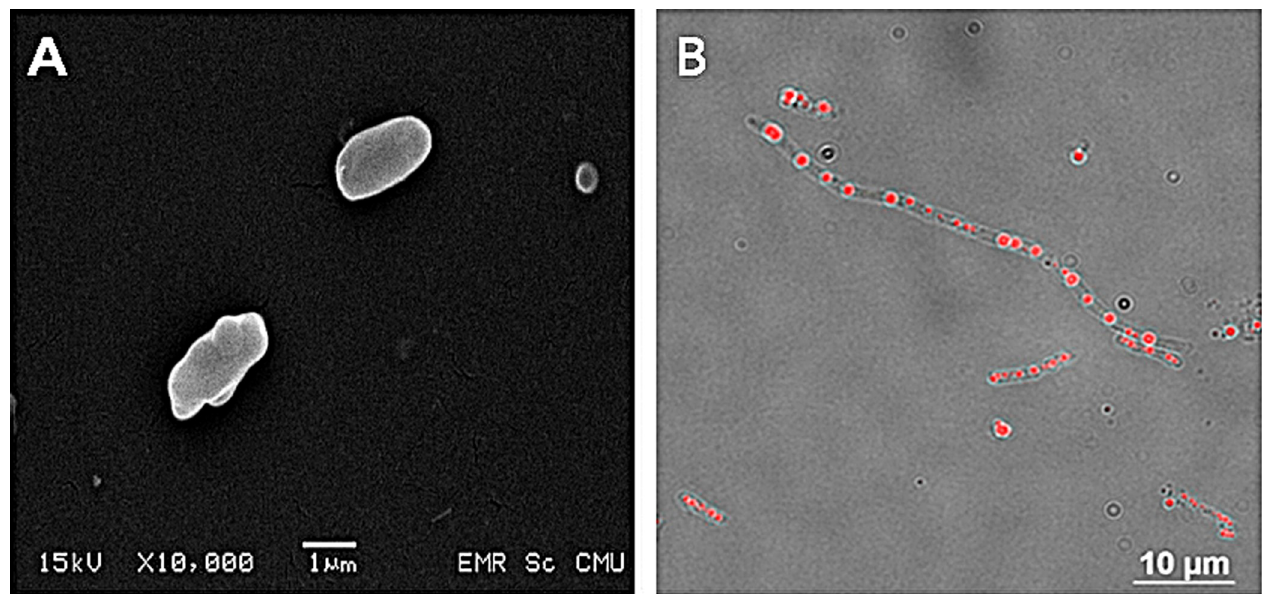
Fig 1. Bacillus drentensis BP17 cells exhibiting PHAs inclusion. (A) Scanning electron microscope (SEM) when grown on nutrient agar (NA) plate at 30˚C for 24 h and (B) Nile red staining under fluorescence microscope when cultivated in Nutrient broth containing 1% (w/v) glucose at 30˚C, 150 rpm for 24 h.